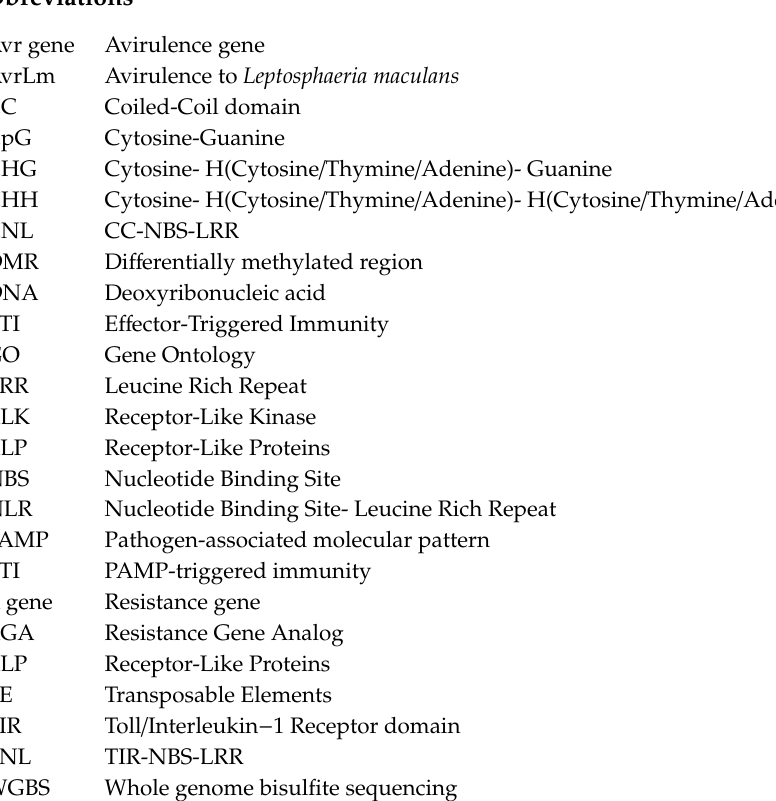
Table S1: List of genes located upstream of deferentially methylated promoters between leaves from control plants and leaves from plants infected with Leptosphaeria maculans of Brassica napus cultivars Westar (susceptible) and Sturt